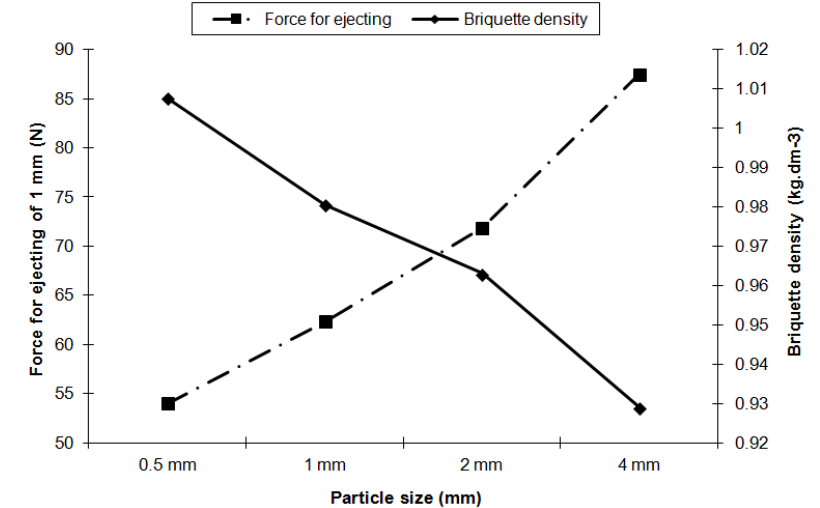
Figure 13. Cumulative interdependence—force required for ejecting, briquette density, and particle size ( w r = 8%; T = 25 °C) at 159